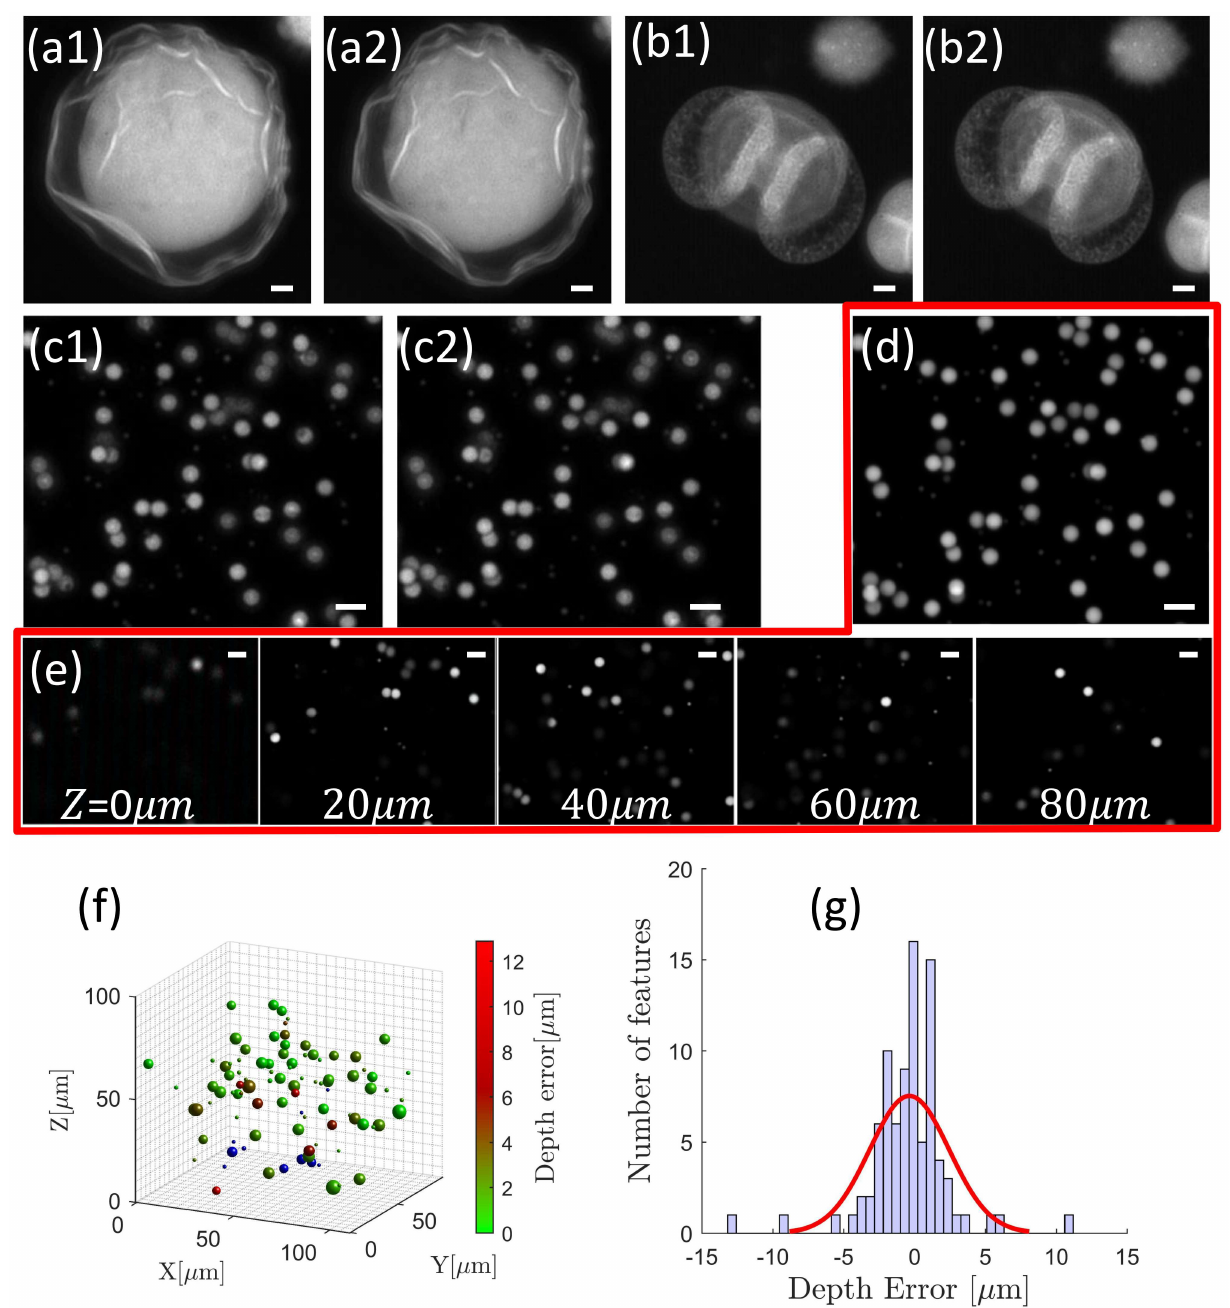
Fig 5. Volumetric imaging and 3D reconstruction. Stereo-pairs of (a-b) pollengrains and (c) fluorescent beadswere capturedin stereo- mode. (d) Sum projection of the stack along z-axis. (e) 5 selectedimages from an image stack consistingof 87 slices taken in standardtwo- photon mode. (f) 3D map of objects with their depth recoveredfrom the stereo-pairin (c). Each object is labeledaccordingto its depth error with a color map that spans from green to red. Blue spheresare unrecognizedobjects in (e), but are present in (d). (g) Histogram of the depth error with superposed normal distribution (red line). Scale bars in (a)-(e) are all 10 μ